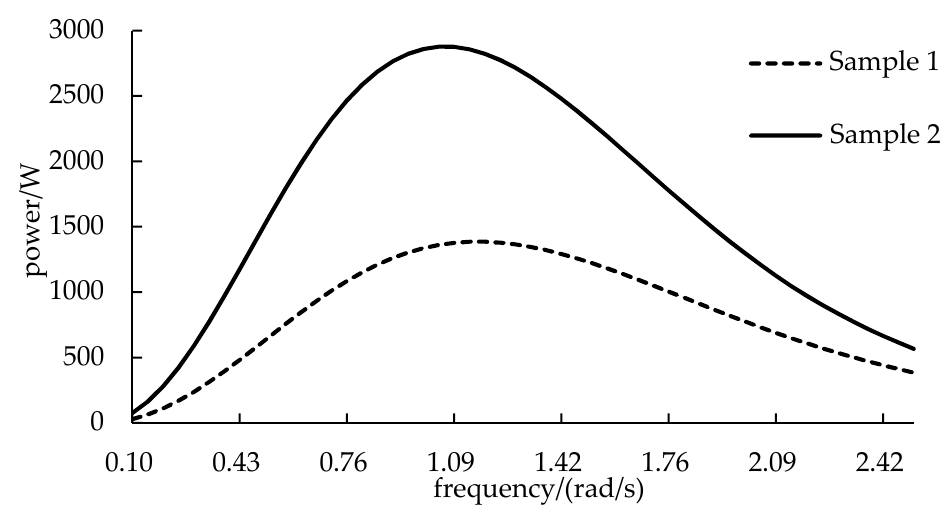
Figure 5. Mean capture power of sample 1 and sample 2.